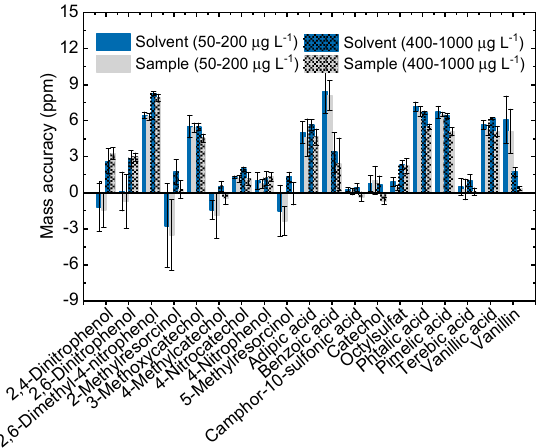
Figure 2. Mass accuracy variation for two concentration levels for both analytes in solvent-only and spiked samples